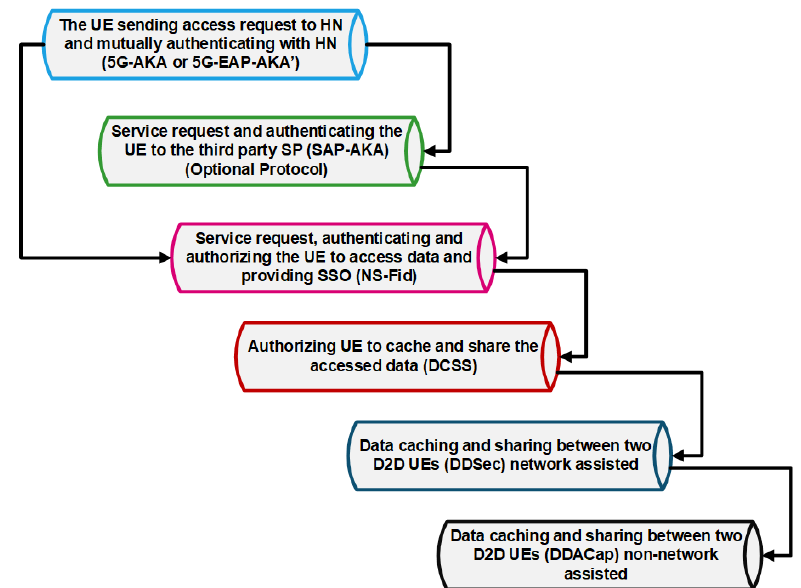
Figure 7. Integrated Security